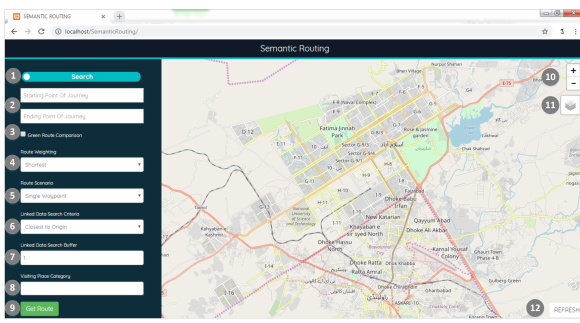
Figure 6. Semantic Routing Application User